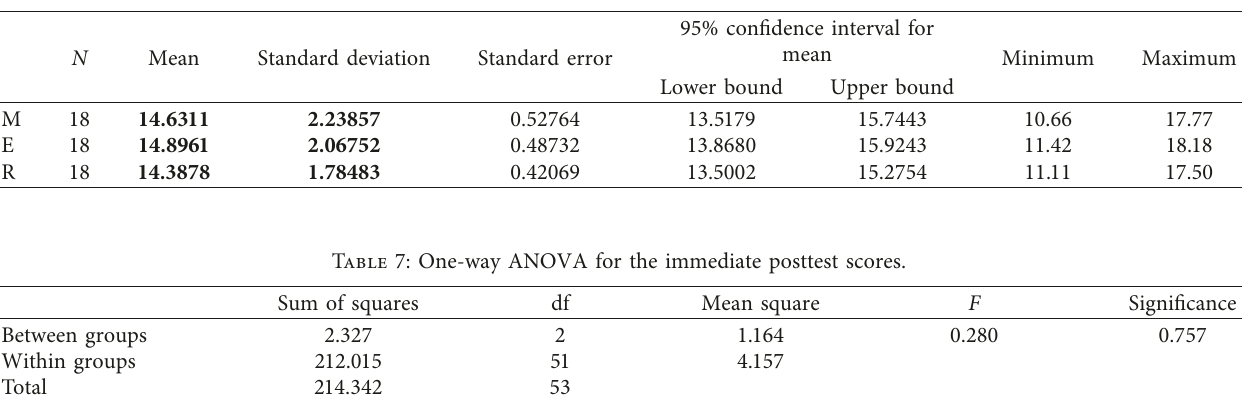
Table 6: Descriptive statistics for the learners’ scores in the immediate